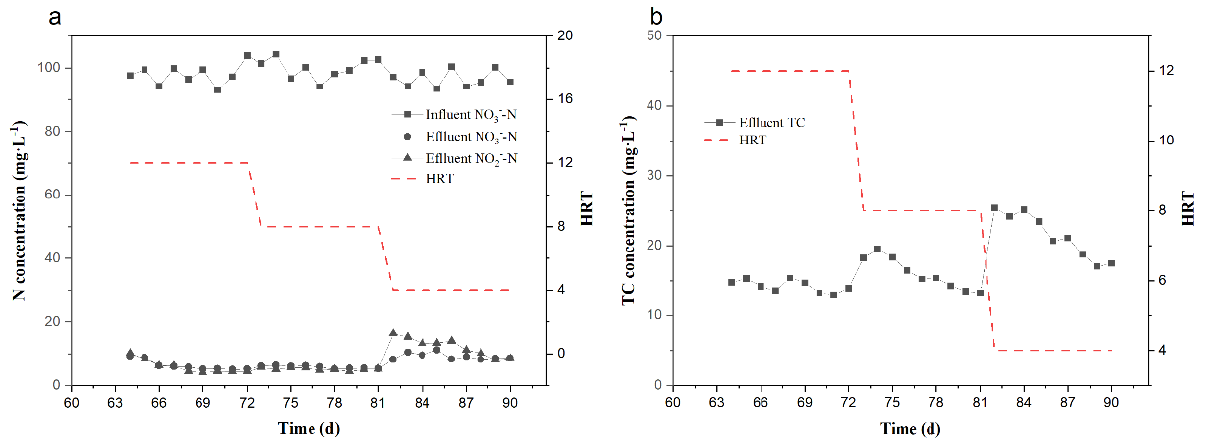
Figure 4. ( a ) Denitrification performance and ( b ) TC removal under different HRT.